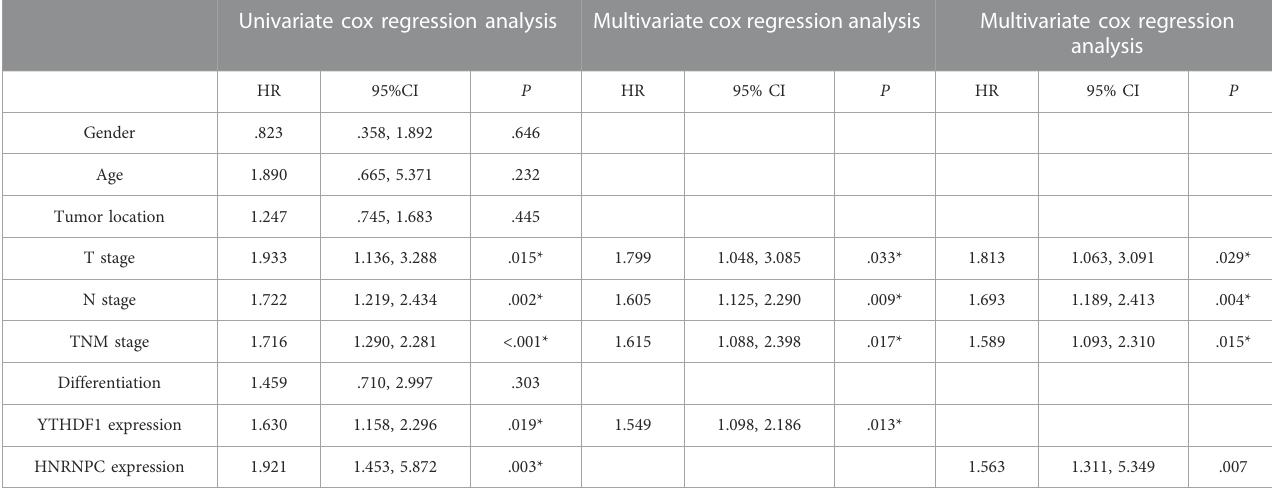
TABLE 3 Univariate and multivariate Cox regression analyses of clinical factors associated with 5-year overall survival on ESCC tissue